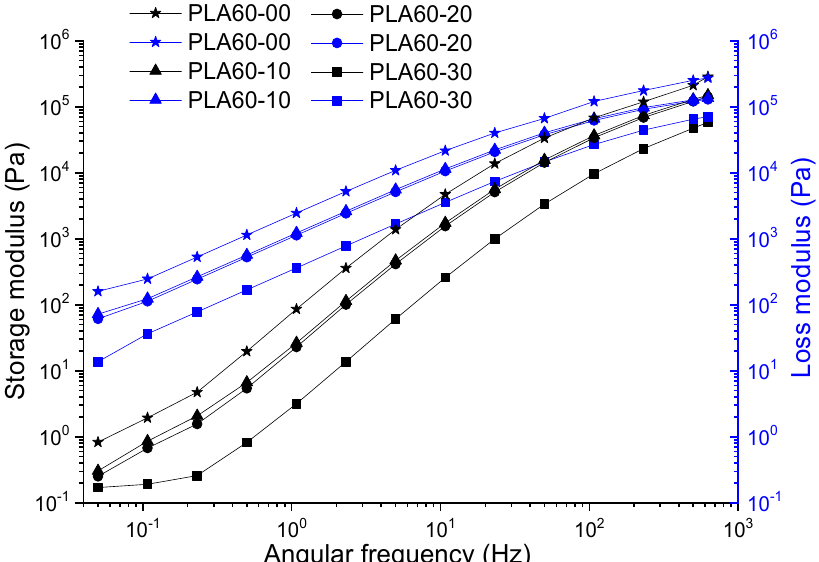
Figure 2. Storage and loss modulus of poly-lactic acid (PLA) and PLA with acetyl tributyl citrate (ATBC) at 10, 20 and 30% extruded to 60 rpm.